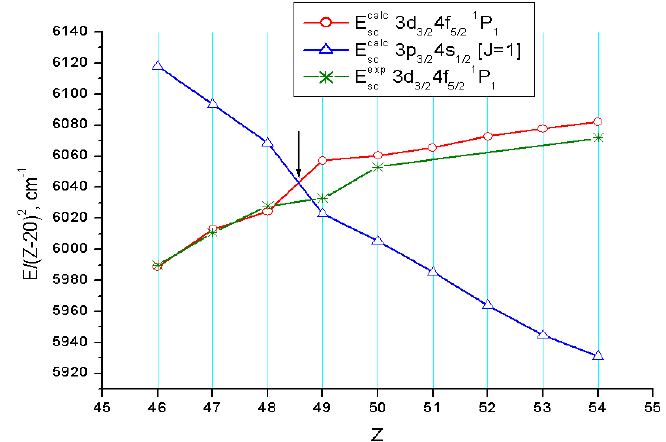
Figure 5. Crossing of upper working 3d 3/2 4f 5/2 [J = 1] energy level with 3p 3/2 4s 1/2 [J = 1] energy level in Ni-like sequence, shown by scaled energy values along Z . The corresponding experimental values for 3d 3/2 4f 5/2 [J = 1] energies are also shown.